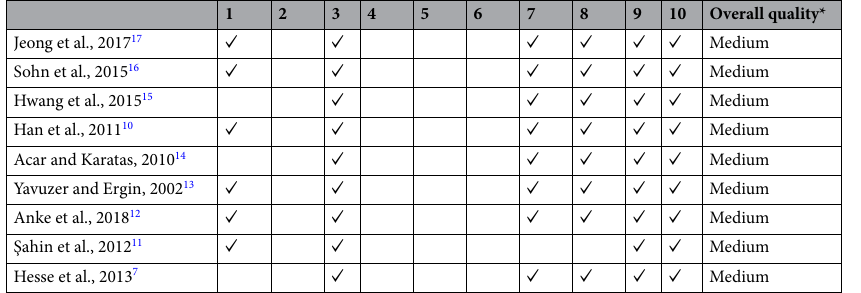
Table 2. Summary of the physiotherapy evidence database (PEDro) scale. 1, random allocation; 2, concealed allocation; 3, baseline similarity; 4, subject blinding; 5, therapist blinding; 6, assessor blinding; 7, more than 85% follow-up for at least one key outcome; 8, intention-to-treat analysis; 9, between-group statistical comparison for at least one key outcome; 10, point and variability measures for at least one key outcome. *Methodological quality: high, ≥ 7 points; medium, 4–6 points; low, ≤ 3 points. w/o: